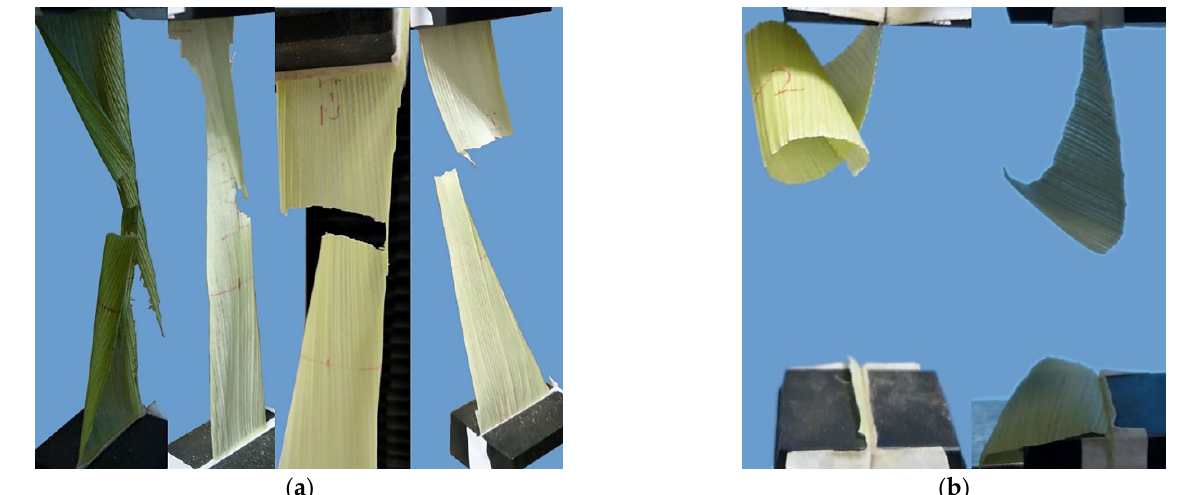
Figure 9. Crack propagation modes of leaf blade under two vein orientations: ( a ) fracture mode of leaf blades in the LTT;